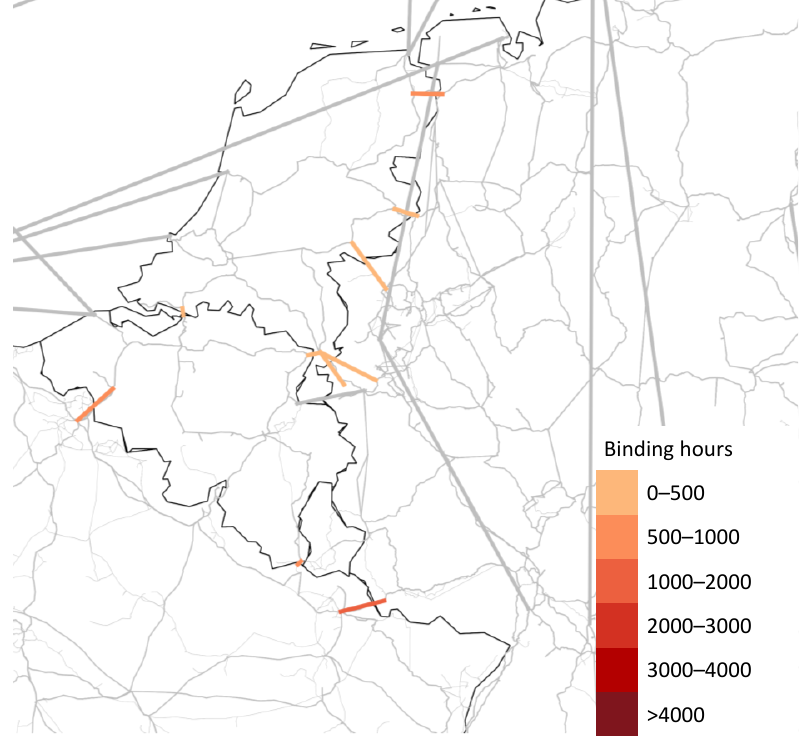
Figure 12. Binding CNEC in the FBMC simulation. These additional exchange restrictions are accompanied by a higher electricity price gap since a full utilization of the exchange capacity can only exist with a price gap in both cases. This is shown by the annual duration curve of the price gap in Figure